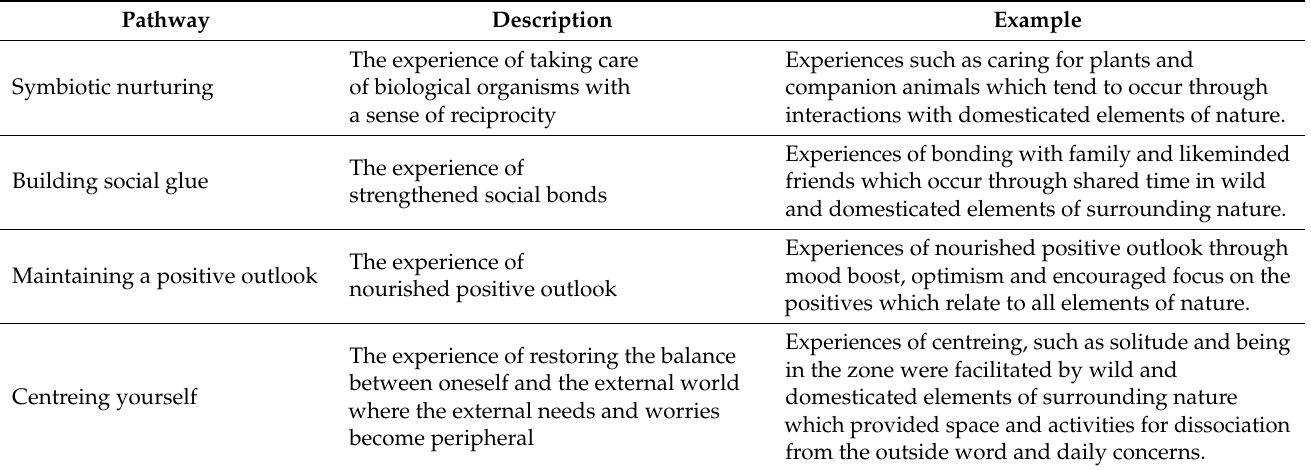
Table 1. Description of nature–wellbeing pathways as perceived by